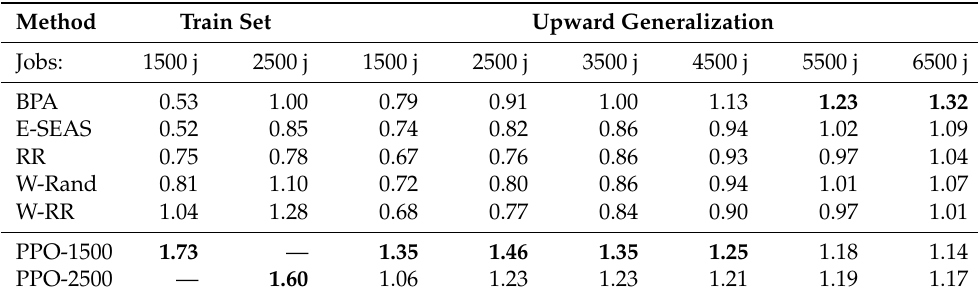
Table 2. Upward generalization of policies that were learned over the fixed job environments with 120 devices and 1500 (or 2500) jobs measured in